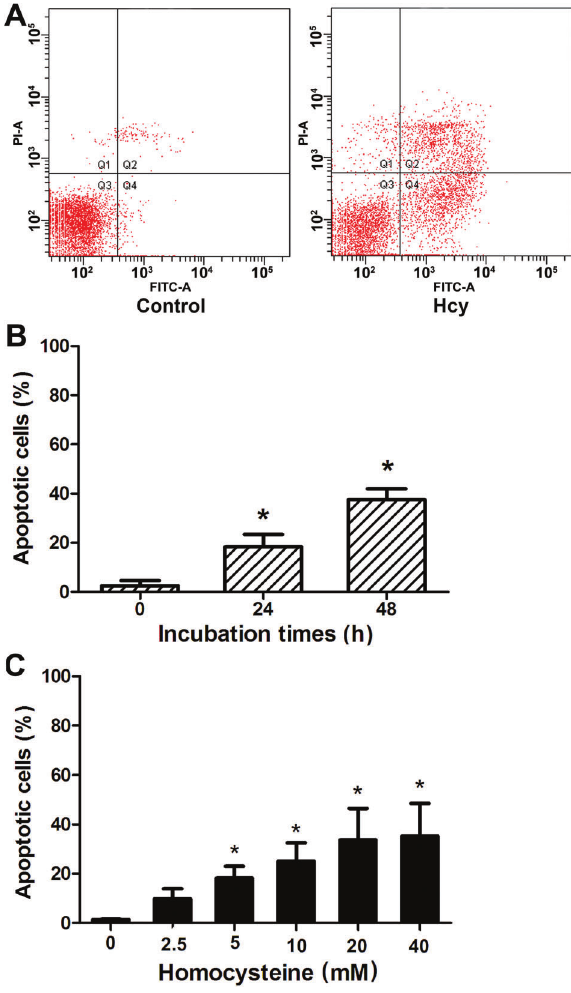
Figure 2. Neuro2a cells were incubated with homocysteine (Hcy) for 24 or 48 h. Apoptotic cell populations were assessed by annexin-V and propidium iodide (PI) staining and fl ow cytometry. A , Representative results of fl ow cytometry for control and